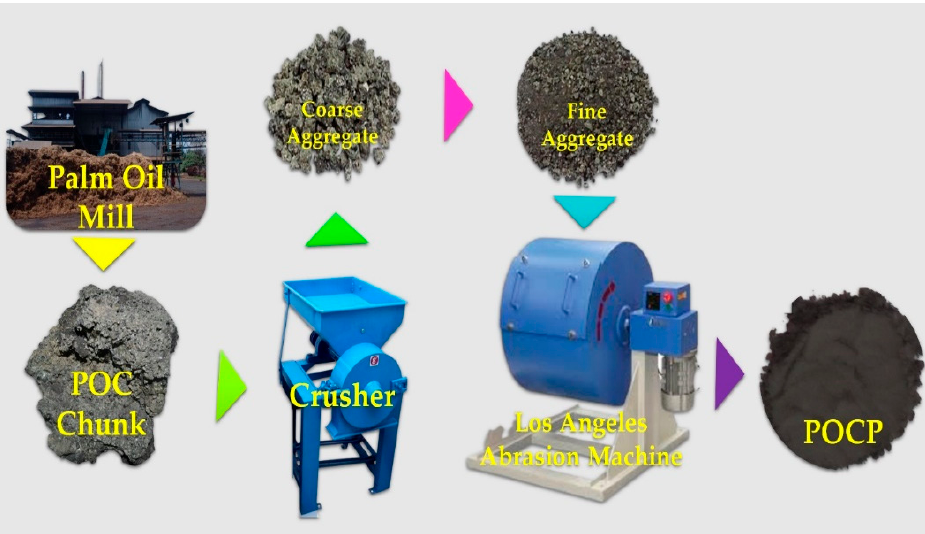
Figure 9. Preparation of POC powder [34]